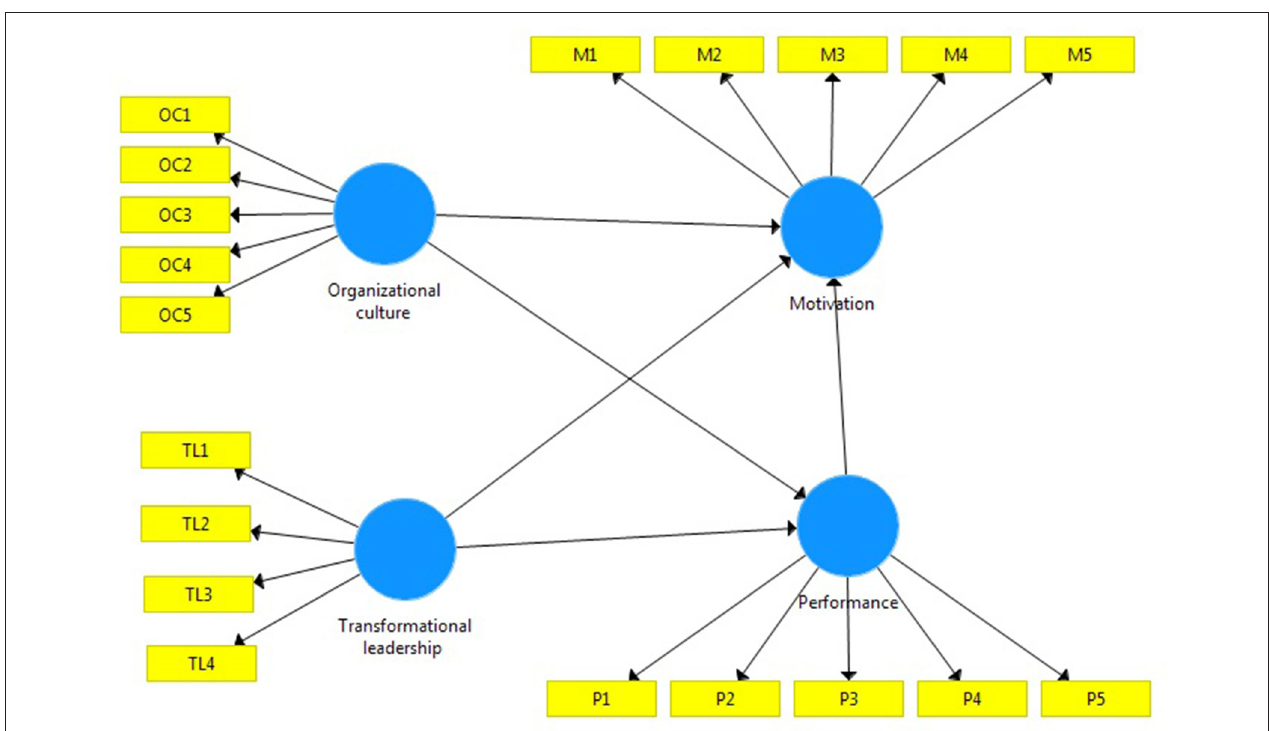
FIGURE 1 | Research